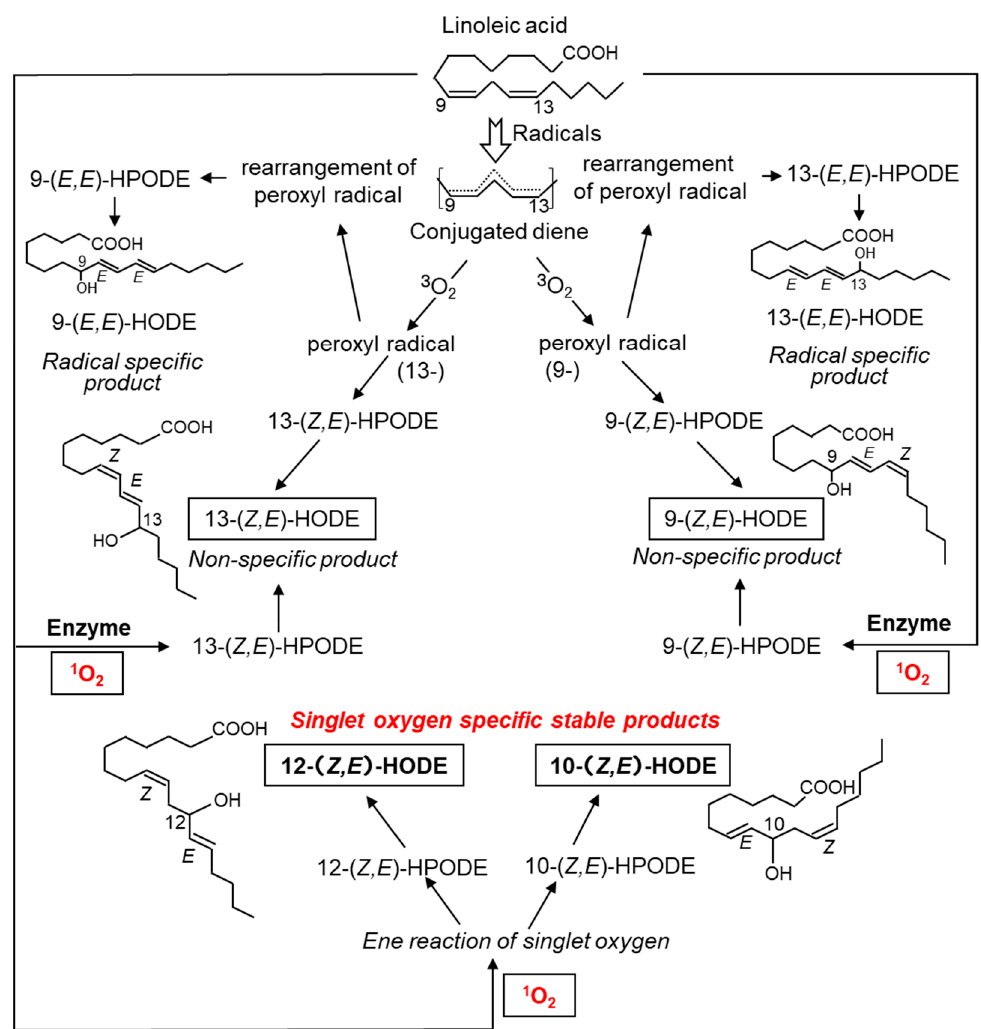
Figure 5. Structures and formation mechanism of hydroxyoctadecadienoic acid (HODE), an oxidation product derived from linoleic acid. 1 O 2 oxidizes linoleic acid to produce 13-( Z,E )-HODE, 9-( Z,E )-HODE, 12-( Z,E )-HODE, and 10-( Z,E )-HODE. 13-( Z,E )-HODE and 9-( Z,E )-HODE are also produced by ROS other than 1 O 2 and by enzymatic oxidation reactions via lipid oxidases. 9-( E,E )-HODE and 13-( E,E )-HODE are produced in a radical-specific manner.